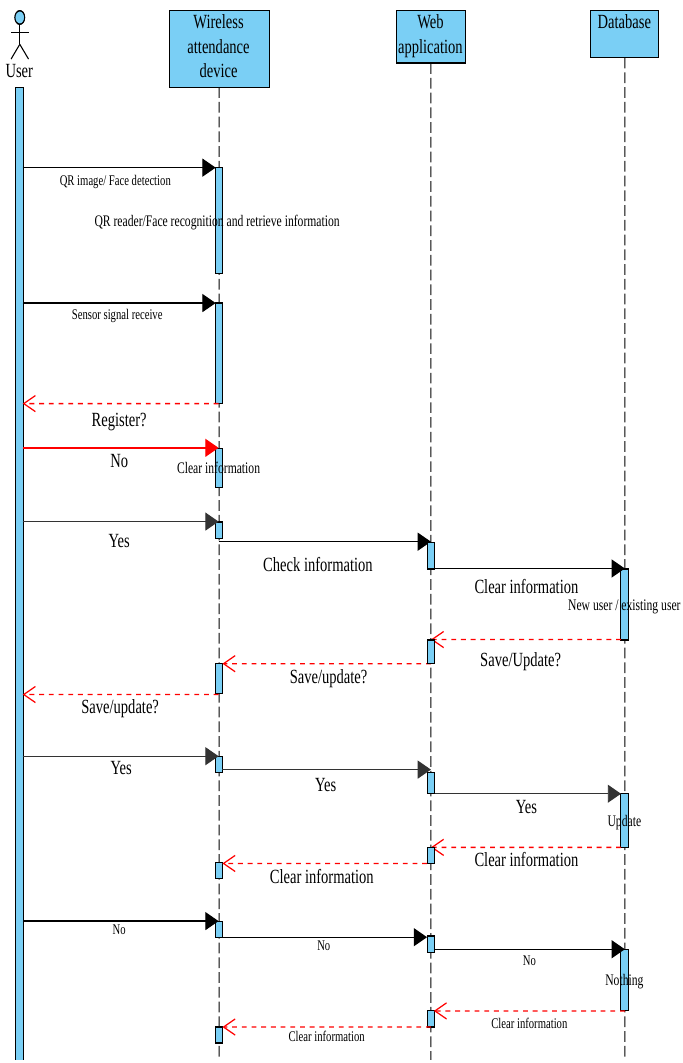
Visual Paradigm Online Free Edition Figure 8. Diagram of the marked attendance